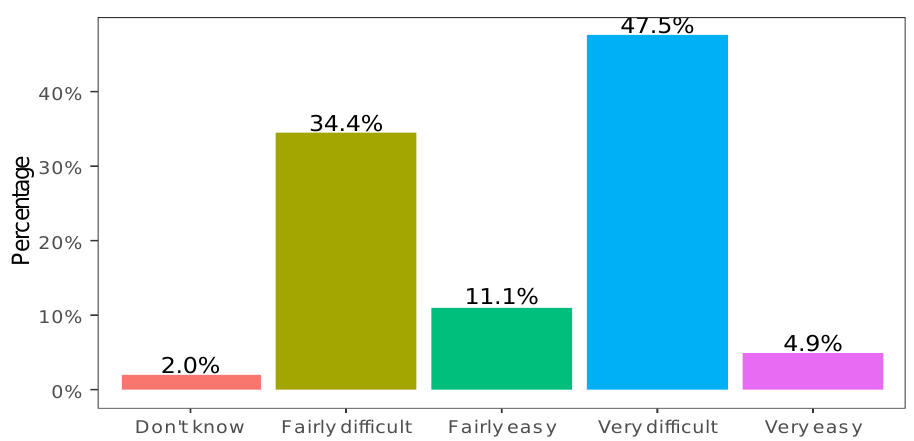
Figure 6. Description of Accommodation Searching